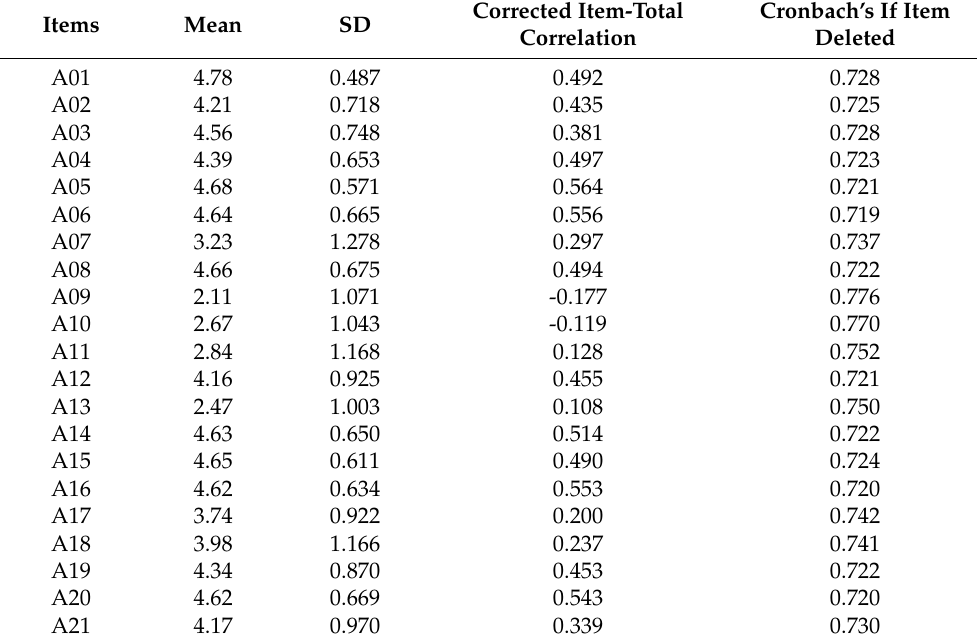
Table 1. Knowledge and attitudes about